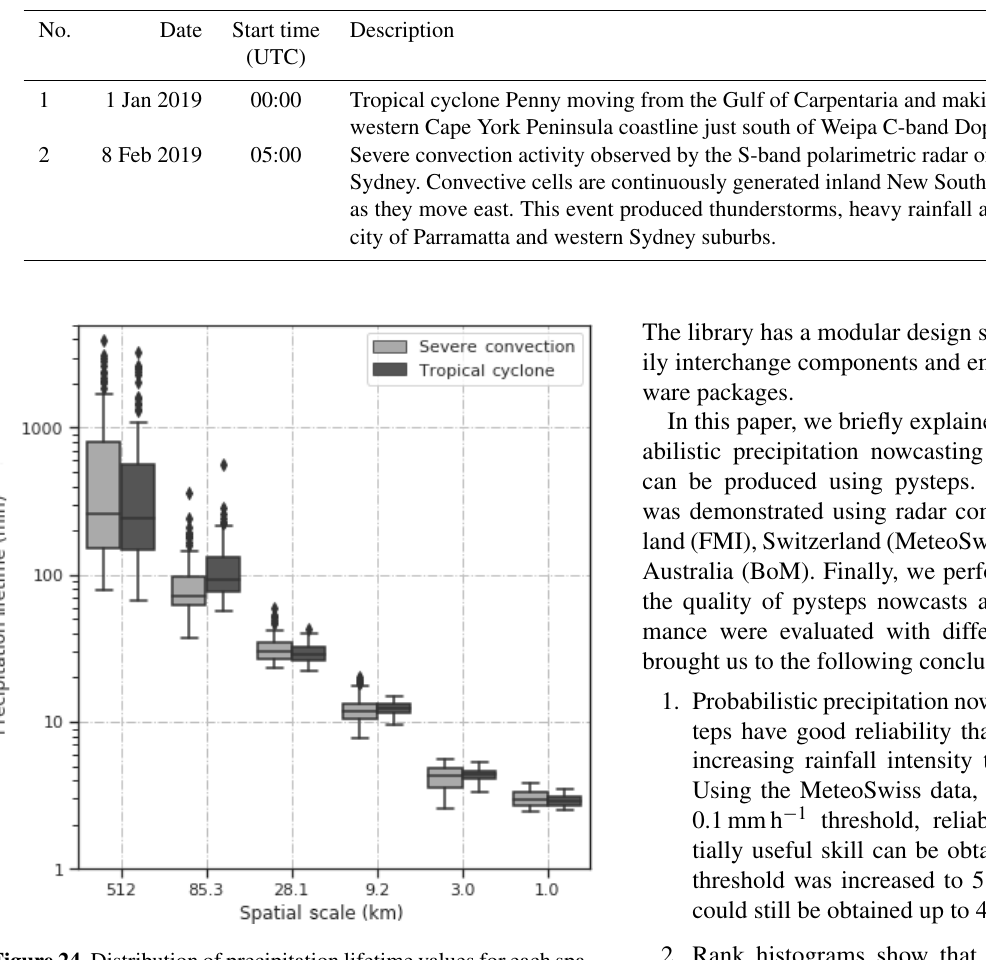
Figure 24. Distribution of precipitation lifetime values for each spa- tial scale during tropical cyclone (event no. 1 in Table 10) and severe convection (event no. 2 in Table 10) case